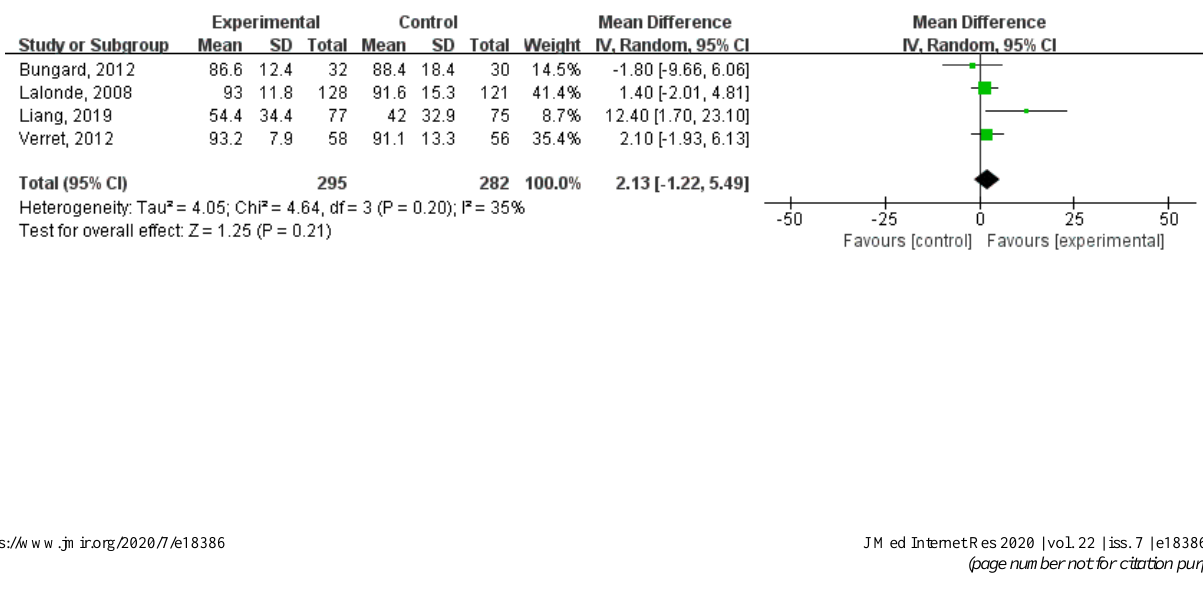
Figure 6. Results of a meta-analysis of the effects of technology-based interventions on time within extended target international normalized ratio range events in oral anticoagulation management. IV: independent variable. Random: random effect